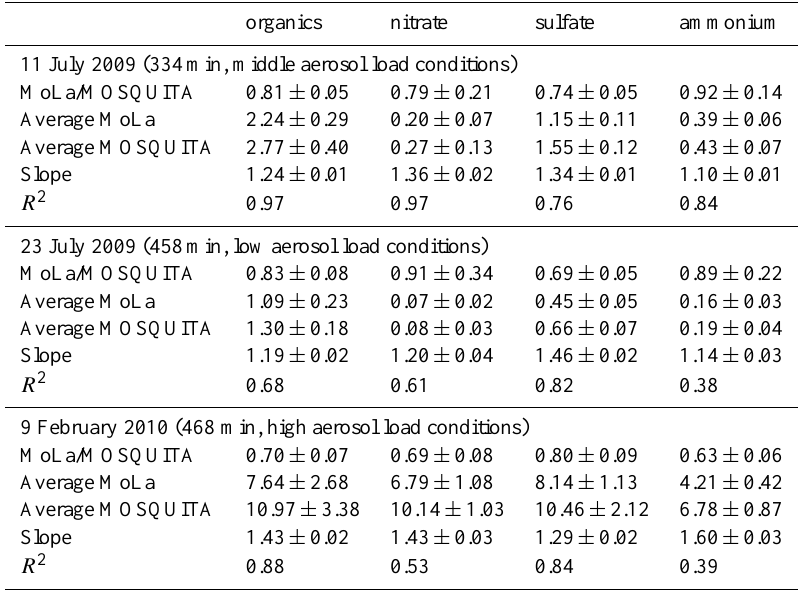
Table 3. Average ratios of MoLa data to MOSQUITA data, average concentration values inµgm − 3 of both HR-ToF-AMS instruments and two correlation parameters ∗ (slope and regression coefficient R 2 ) for the three intercomparison time intervals for the measured variables sub- micron particulate organics, nitrate, sulfate and ammonium. Chloride data are not listed, because ambient values were below the detection limit most of the time. The given uncertainties represent one standard deviation. organics nitrate